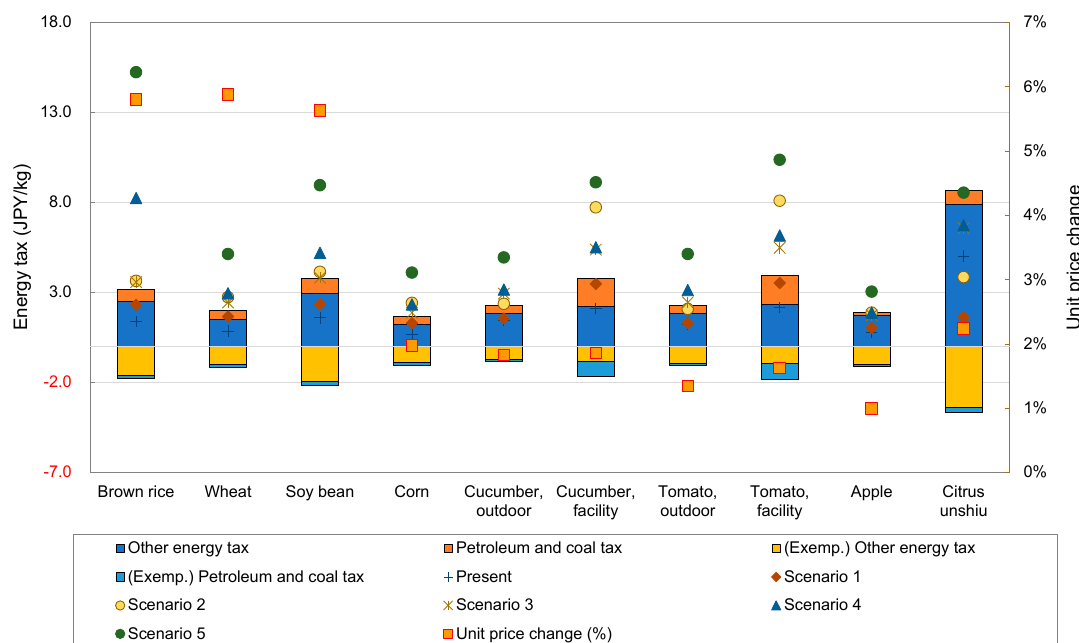
Figure 2. Changes in product taxes and product prices in agriculture under different taxation scenarios. The bar graphs show the present taxation breakdown. The percentage change in product prices compares the present with Scenario 5.